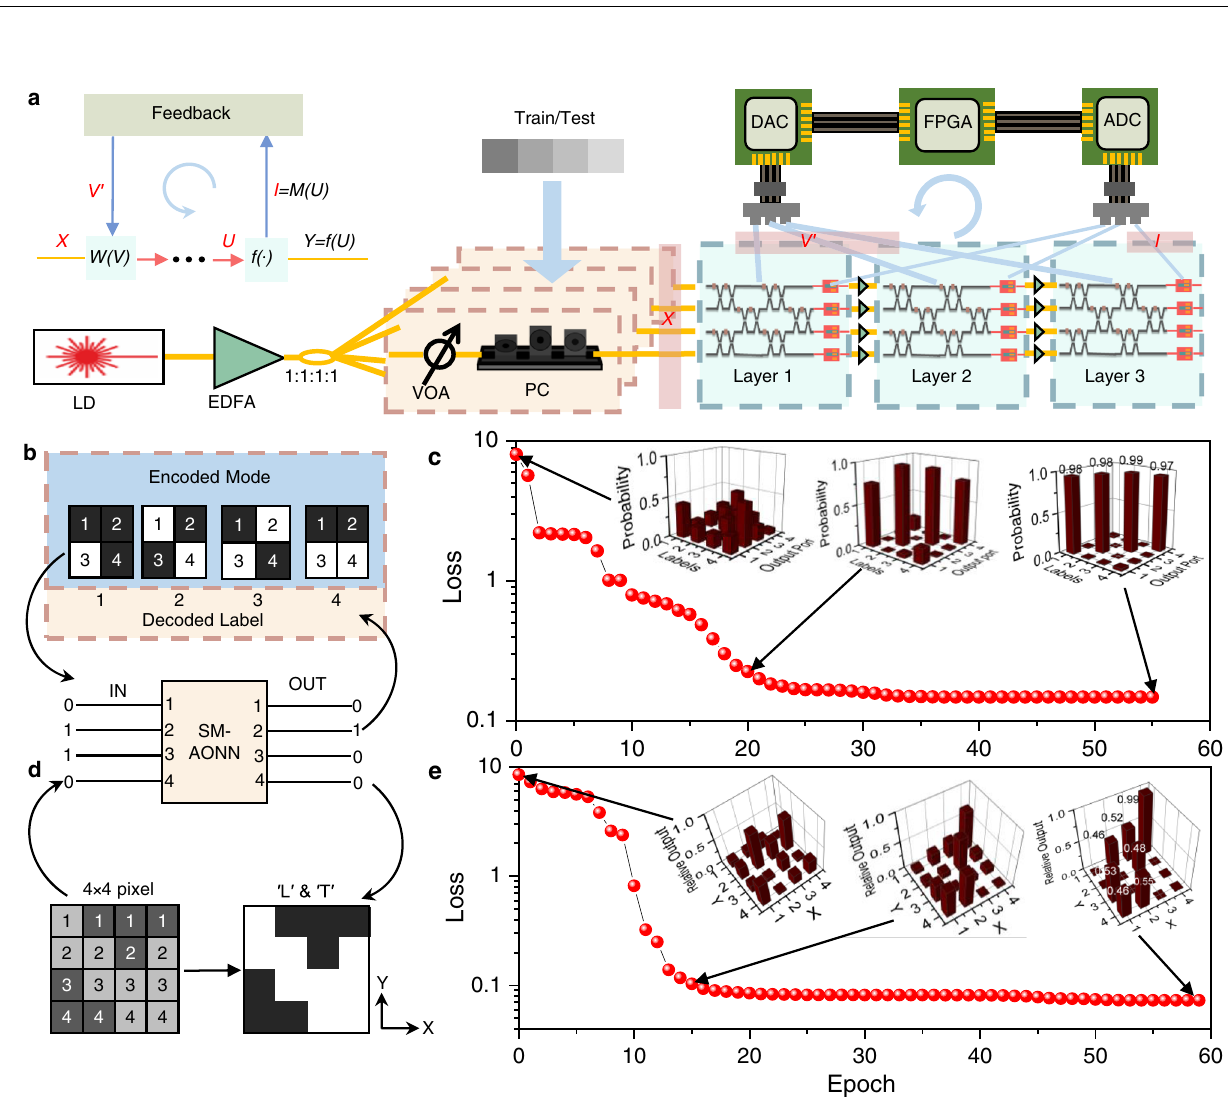
Fig.3|Three-layerSM-AONN.a Thephotooftheconnectedthree-layernetworks. b The packaged single layer within one chip. c The false-color image of MZI mesh andAONUs.Black,Siwaveguide.Green,electrodesofthermally-tunableMZI. d The